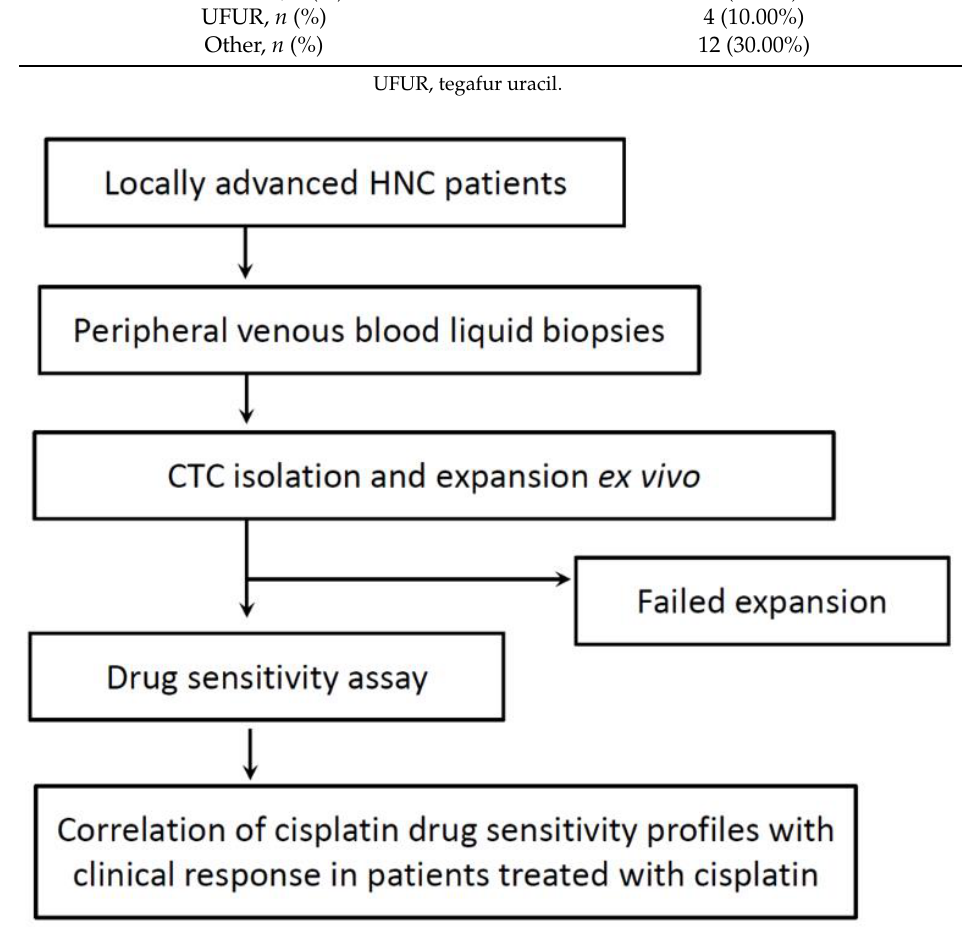
Figure 1. Overview of the study procedure.